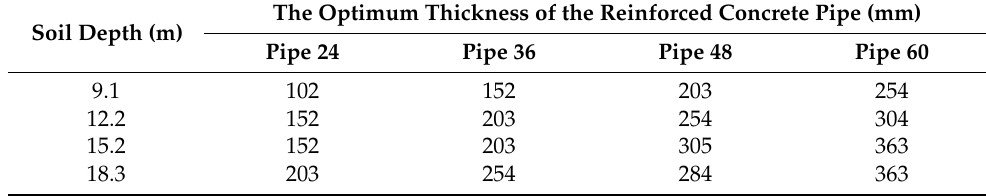
Table 5. The optimum thickness of the analyzed reinforced concrete